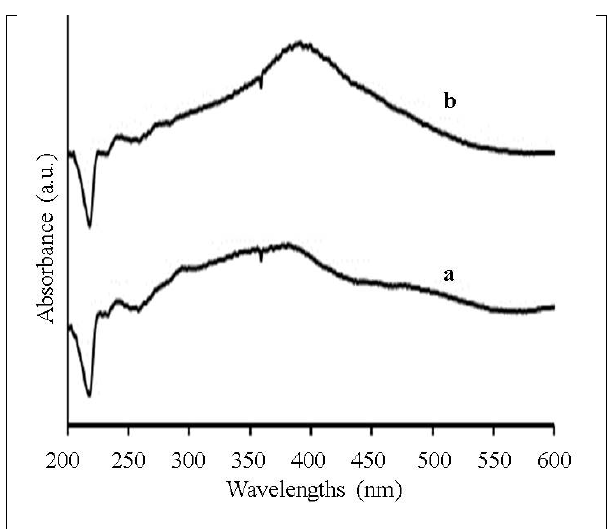
Fig. 1. FT-IR spectra of the as-prepared Cr 2 O 3 nanoparticles at a) 500 ºC and b) 600 ºC